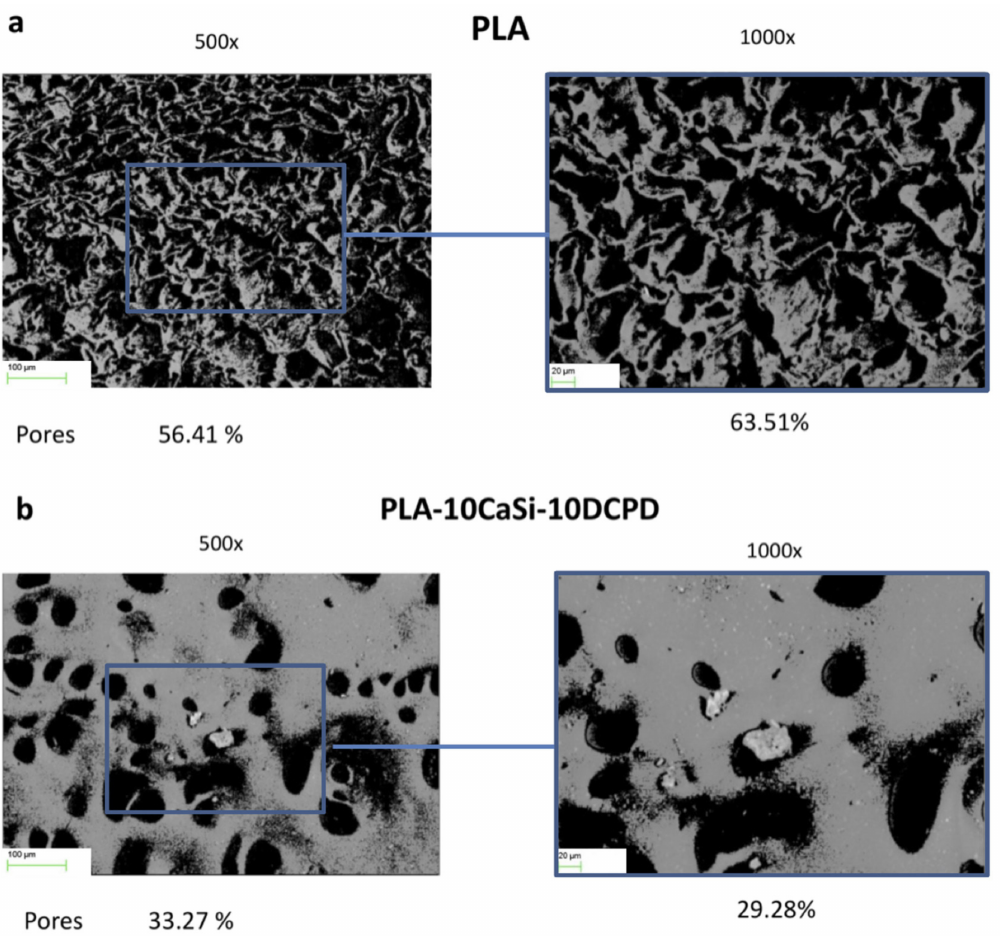
Figure 1. Surface porosity evaluation of PLA ( a ) and PLA-10CaSi-10DCPD ( b ) sca ff olds on one random area at 500 × and 1000 × magnifications. Mineral doped formulation revealed a more compact surface, with a lower number of porosities when compared to pure PLA